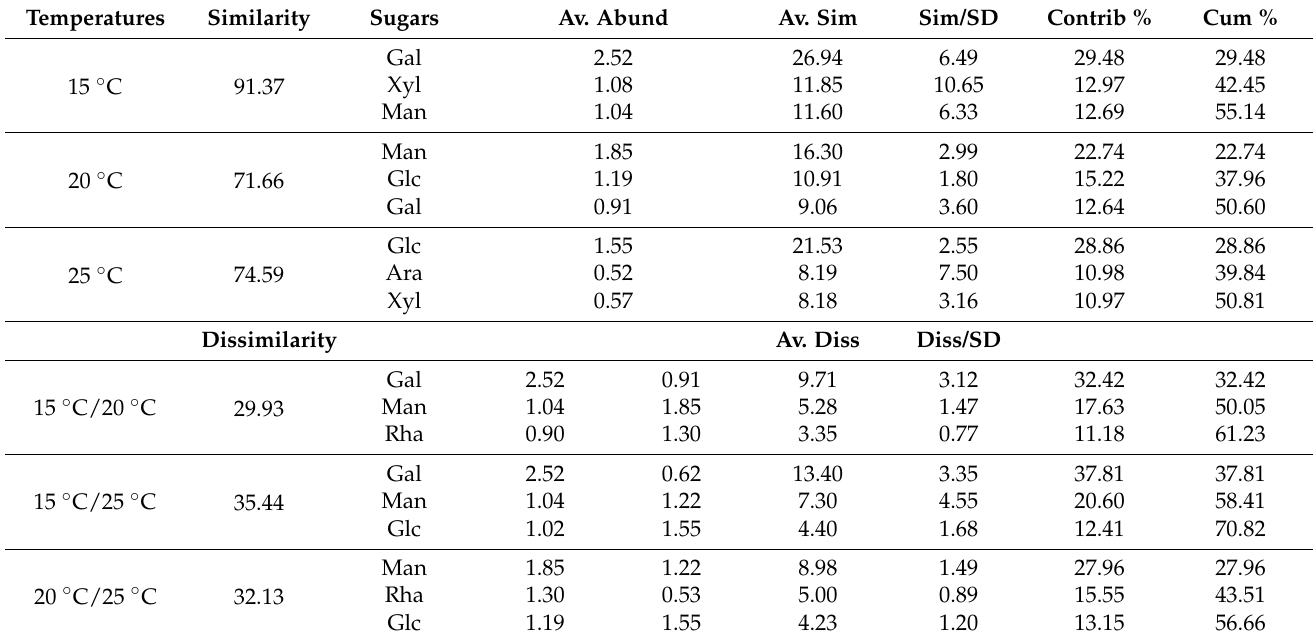
Table 8. SIMPER analyses showing the average similarity and dissimilarity among temperatures, related with n-MDS analysis. Temperatures